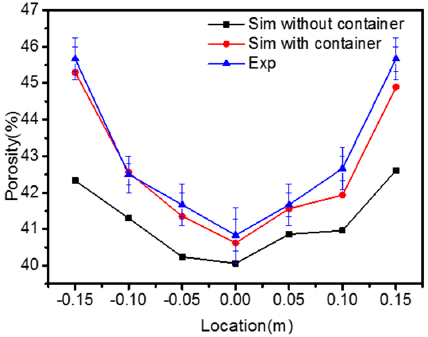
Figure 9. Comparisons of simulated (with and without containers) and experimental bottom porosity distribution (BPD) of the pellet pile.